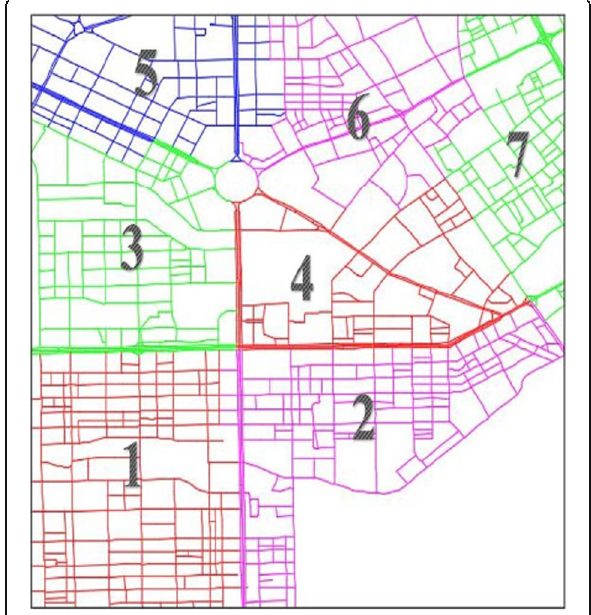
Fig. 3 Local road network scope of Changchun and traffic guidance sub-region division